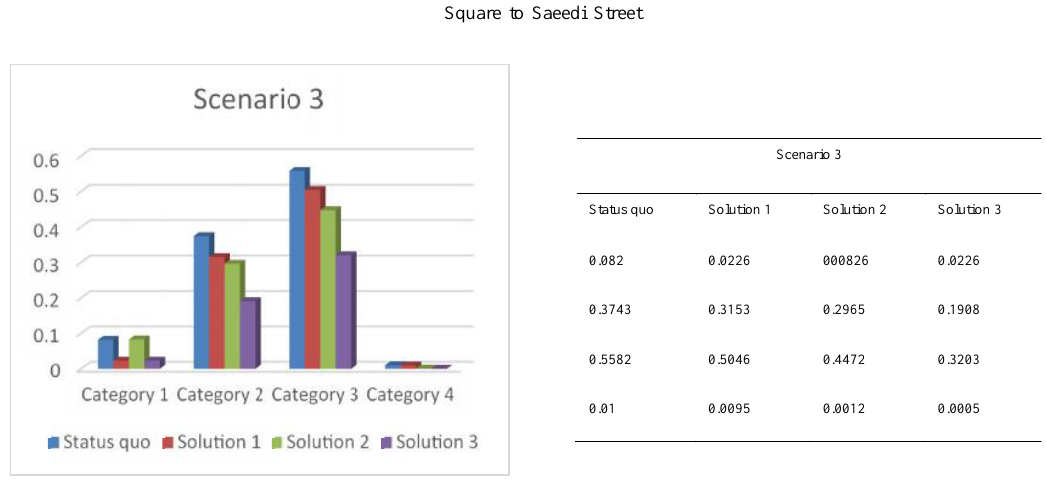
Fig. 9: The results of Vehicle-vehicle accident probabilities after the adoption of the proposed solutions in Shahid Sabari (Ajodanieh) Street